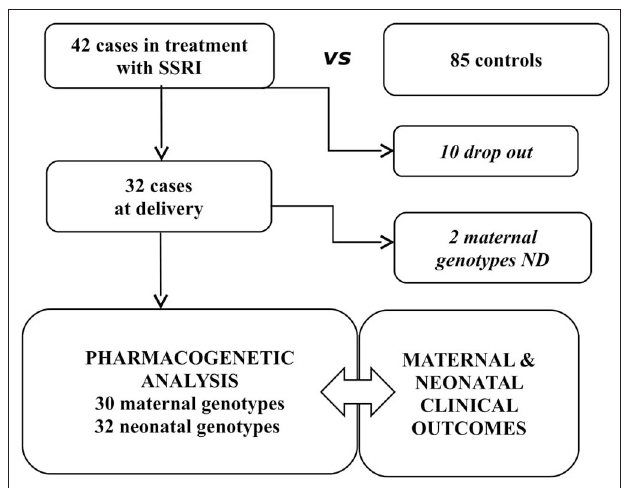
FIGURE 1 | Study population.